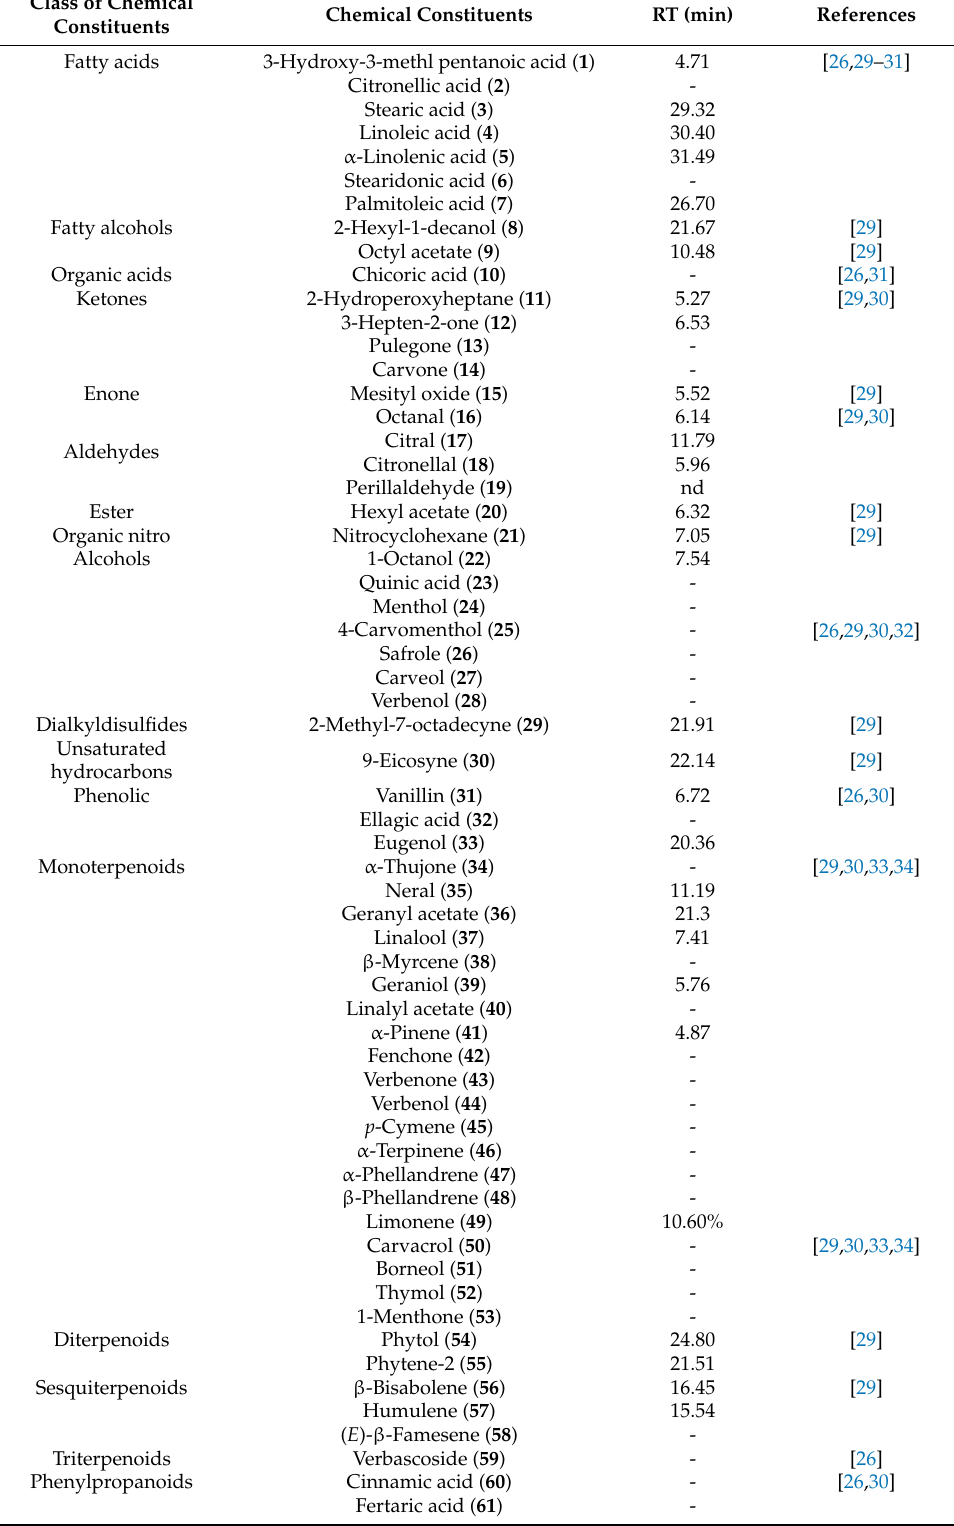
Table 1. The Chemical Constituents of O. americanum